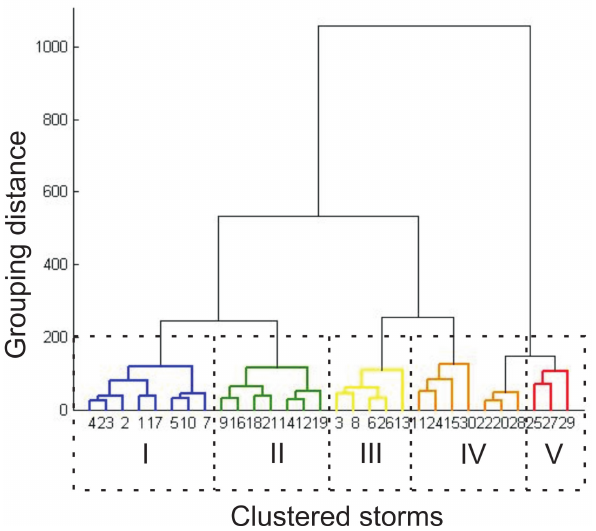
Fig. 3. Storm classification using cluster analysis (solid lines) and supervised classification (dashed lines). Numbers in the x-axis are clusters’ identifiers.